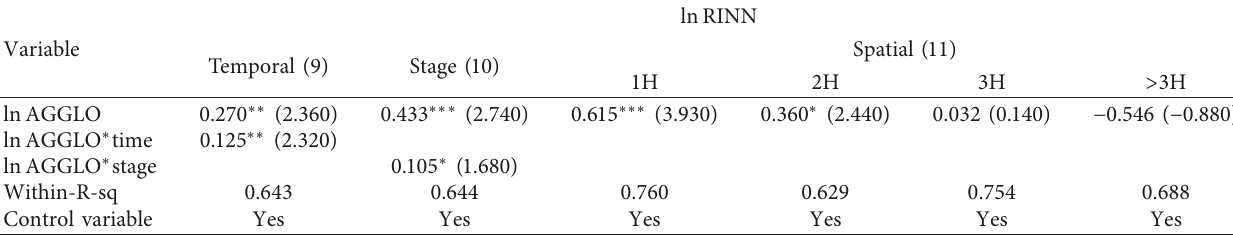
Table 8: Heterogeneity test